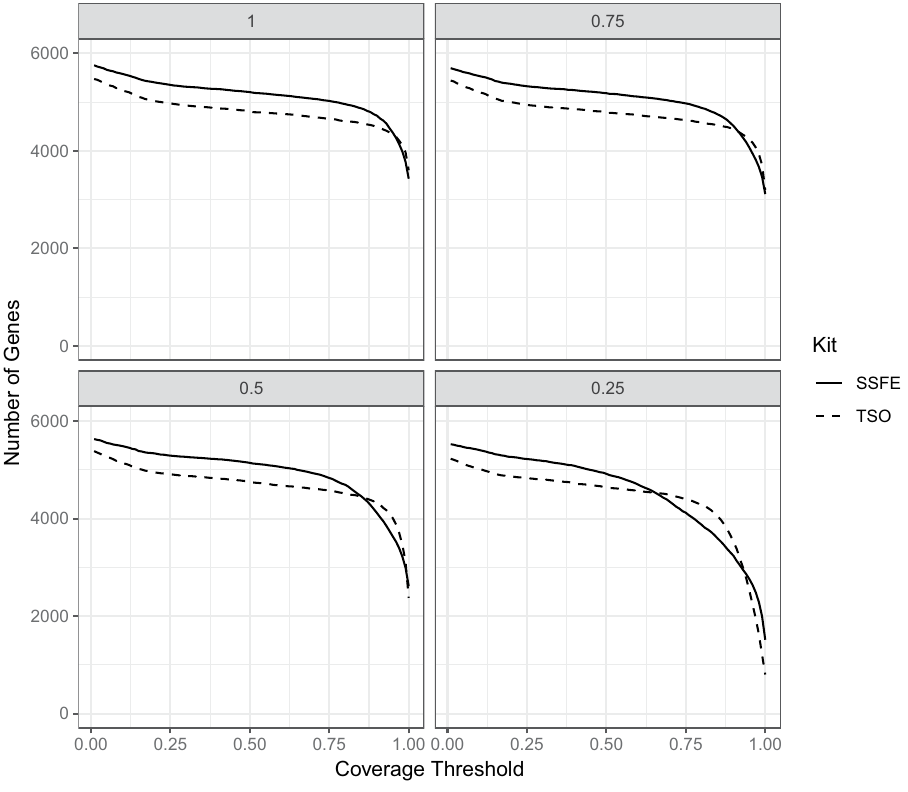
Figure 3. Proportion of genes covered to varying levels in downsampled datasets representing 12–48 samples being included in a single sequencing run. A reduction in the number of genes covered to a high level can be seen with the data down-sampling.